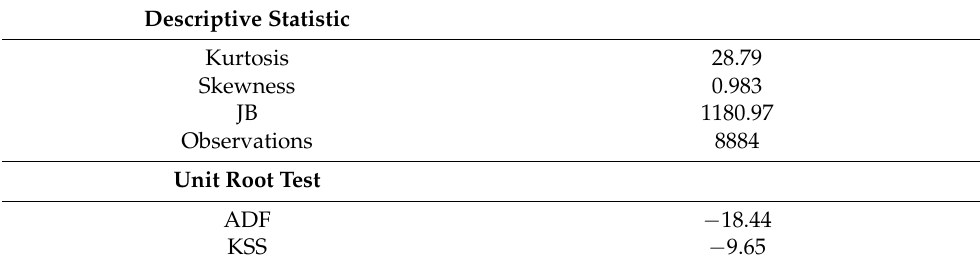
Table 1. Descriptive statistics and unit root tests.